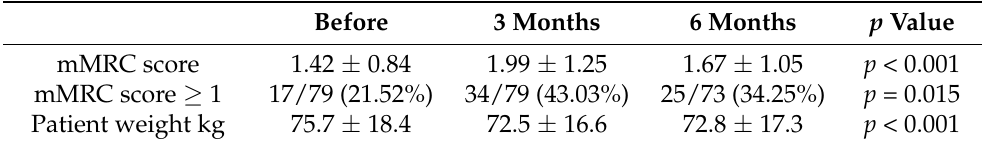
Table 3. Self-reported dyspnea (mMRC questionnaire) and patient weight before COVID-19, 3 months and 6 months after